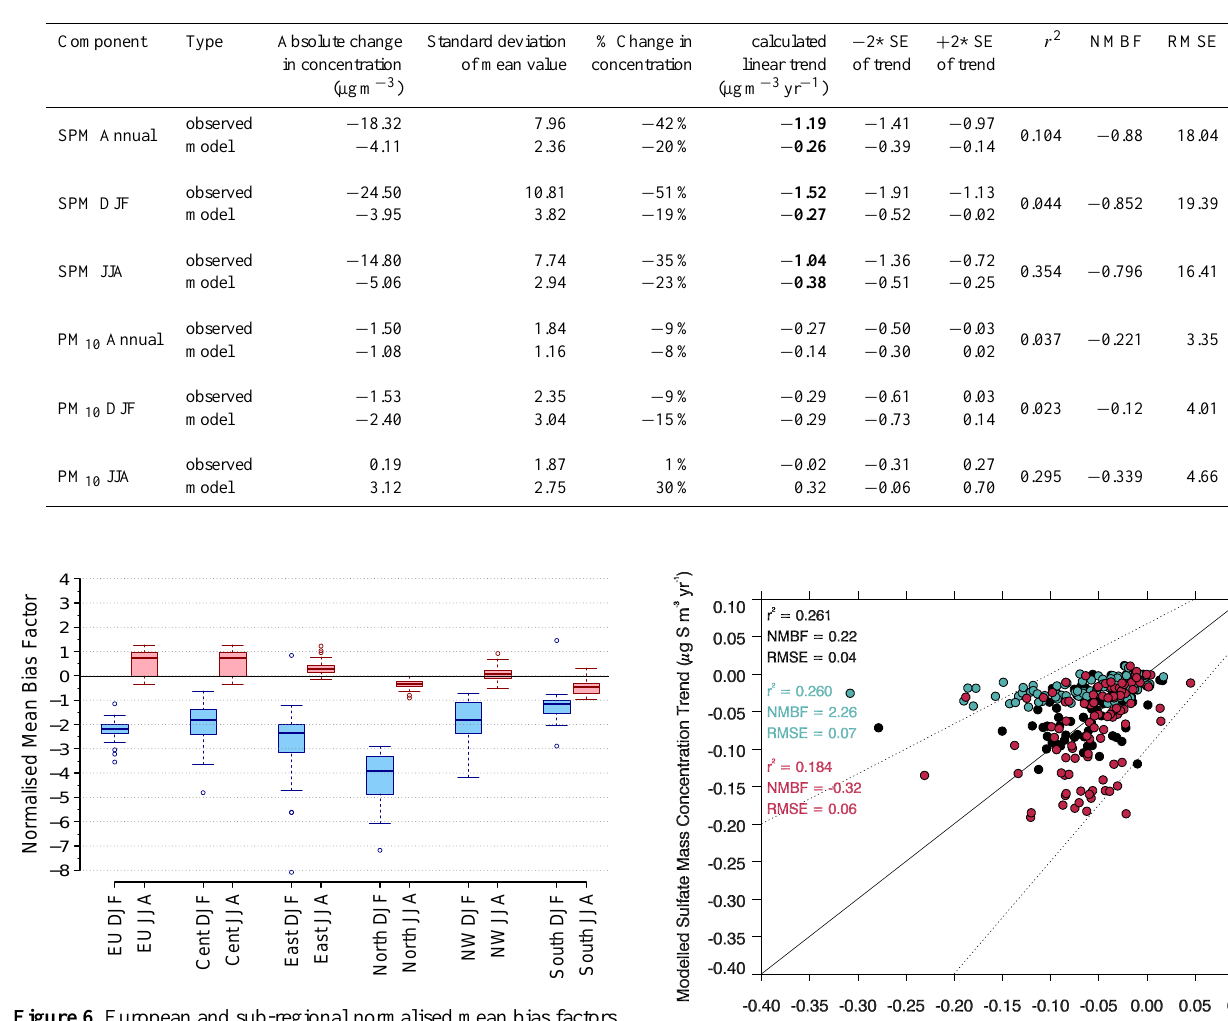
Table 3. Statistical summary of modelled and observed annual and seasonal (DJF and JJA) mean SPM concentrations at all long-term ( > 20 years of data) measurement sites (34 sites) between 1978 and 1998. A similar comparison is presented for PM 10 mass concentrations at all long-term ( > 10 years of data) measurement sites (16 sites) between 1997 and 2009. Absolute and relative (%) changes in concentrations are calculated as the difference between the mean of the initial 5 years of data minus the mean of the last 5 years of data. Trends that are above or below the value of twice of the standard error of the trend (95% confidence) are highlighted in bold.